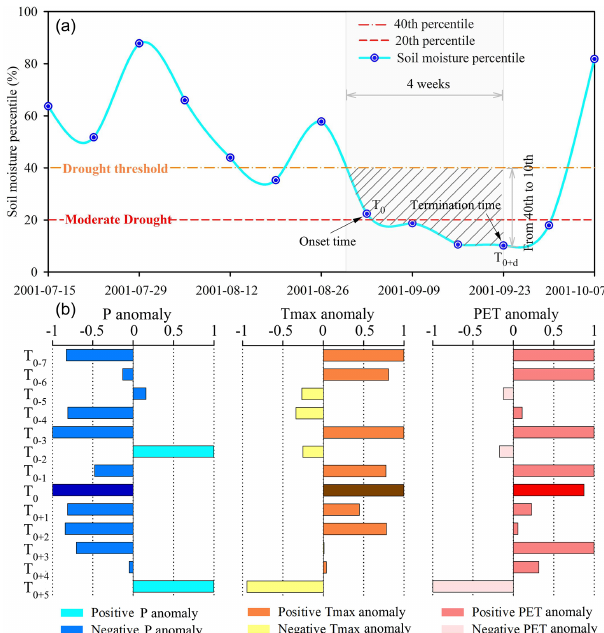
Figure 1. A concept map for identifying flash droughts. (a) The evolution process of flash drought is identified by the rapid deple- tion of soil moisture percentile; t 0 denotes the drought onset time; t 0 + 2 represents the termination time where the rapid decline of soil moisture ends; and the T 0 − 7 – T 0 − 1 denotes 1–7 weeks prior to T 0 , while T 0 + 1 – T 0 + 5 represents the lagged 1–5 weeks of T 0 . The pe- riod T 0 – T 0 + 3 is the onset–development stage of flash drought. Data are from the grid cell (39.875 ◦ N, 116.375 ◦ E) where the city of Bei- jing is located. (b) The bar of the anomaly values of three hydrom- eteorological variables (i.e., precipitation, maximum temperature, and potential evapotranspiration) in the adjacent weeks to drought onset ( T 0 − 7 – T 0 + 5 ). The light color represents a positive anomaly, while the dark color denotes a negative